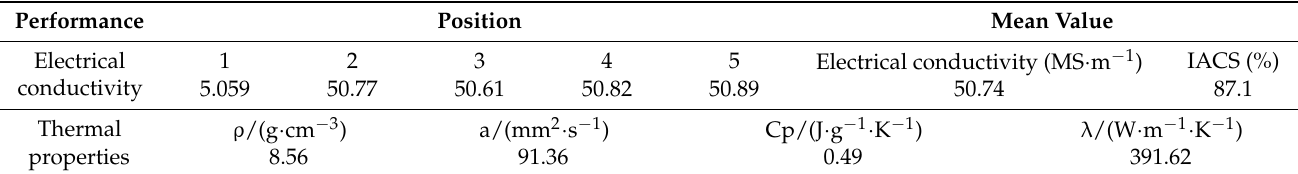
Table 1. Electrical and thermal properties of Cu- rGO composites at room